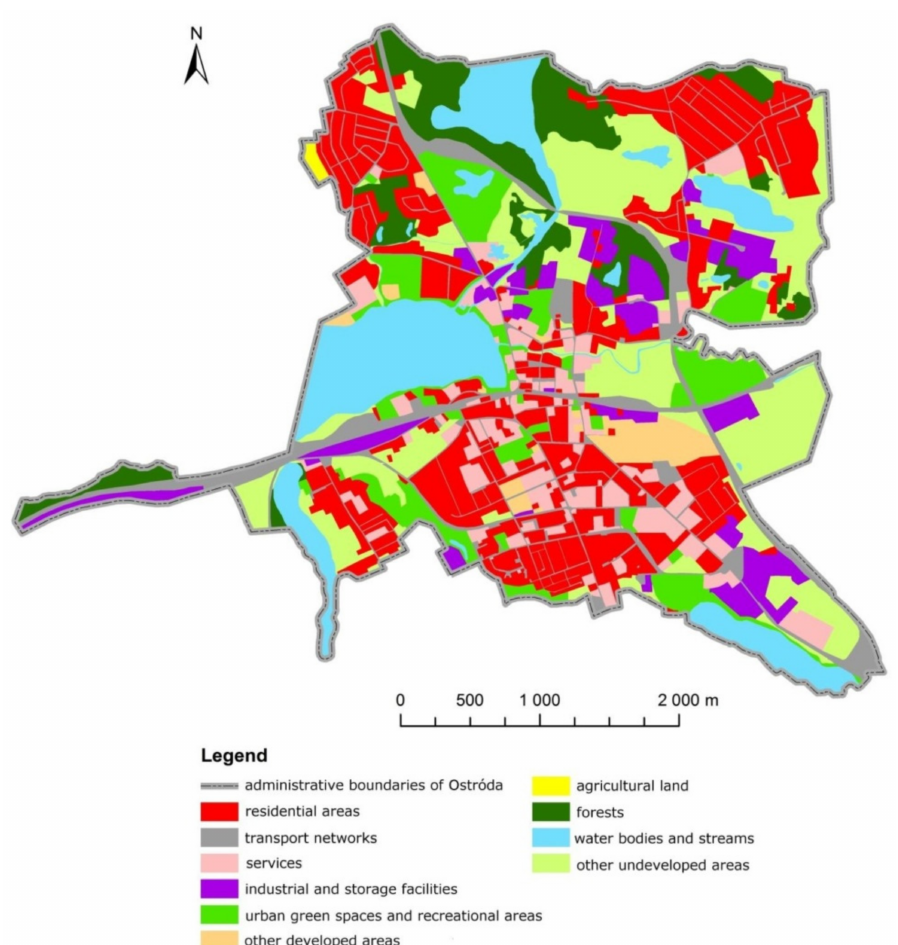
Figure 5. Land-use structure in the town of Ostr ó da in